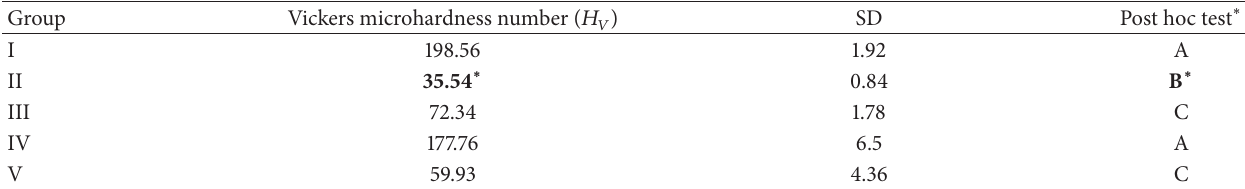
Table 1: Comparison of Vickers microhardness among